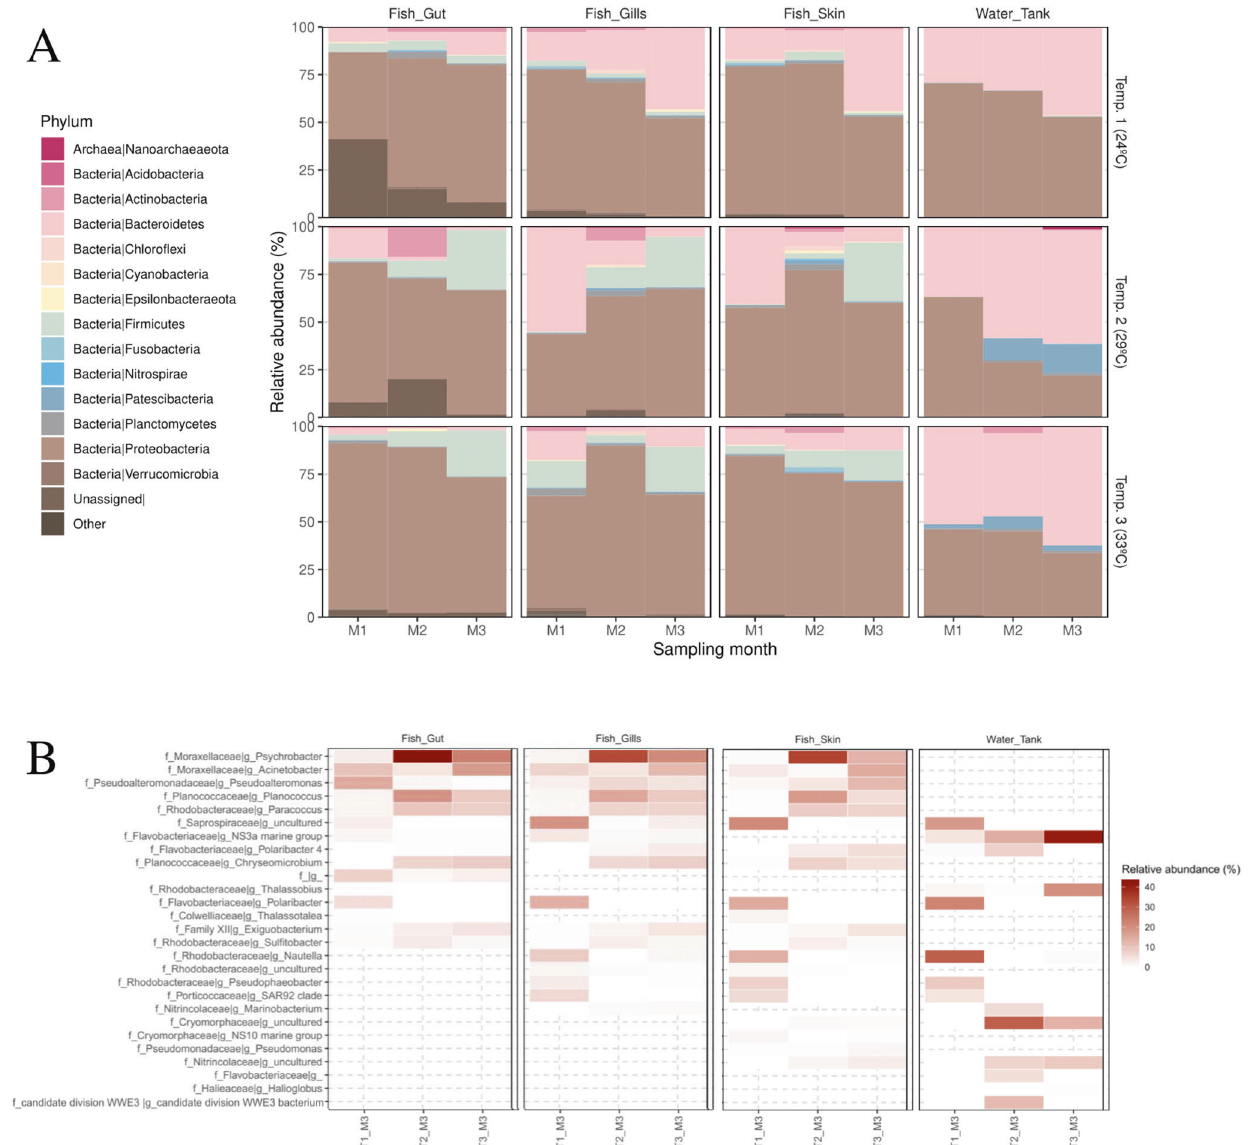
Fig. 3 Taxonomical shifts in greater amberjack and water microbiotas throughout marine heatwaves simulation in RAS systems. A Bar graph showing the taxonomical composition of the bacterial communities from the different fi sh mucosal tissues and the water tanks (M1-M3 and T1 – T3), at the phylum level (mean relative abundance). Within each bar, different colors were assigned to the 15 most abundant phyla, grouping the remaining ones in the category “ Other ” . For the complete composition pro fi le, see Supplementary Table S5. B Heatmap displaying the mean relative abundance (%) of those genera that were found to be differentially abundant in relation to each of the three temperature categories (T1 – T2 – T3). Signi fi cance was assessed with an ANOVA test upon the CLR-transformed genera